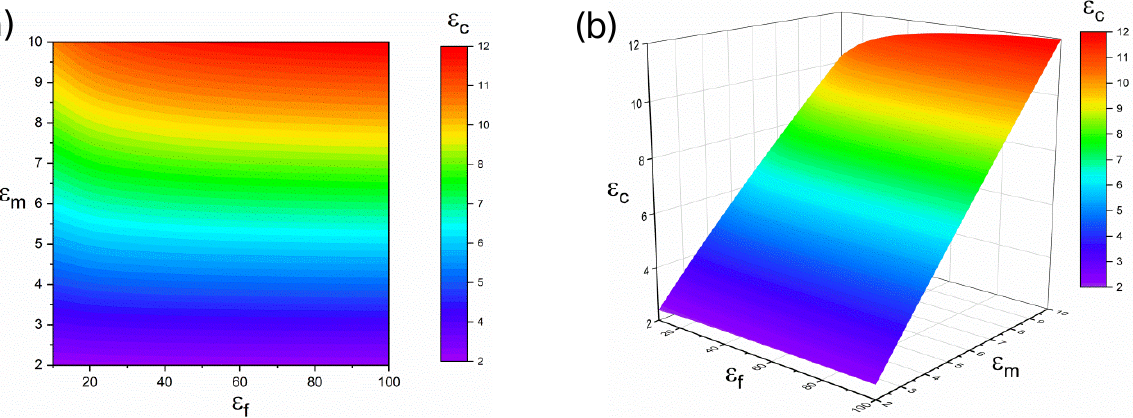
Figure 4. The dependence of ε c to the ε m and ε f when R i = 10 nm, R = 100 nm, V f = 0.1 and ε i = 20 ( a ) contour plot; ( b ) 3D plot.